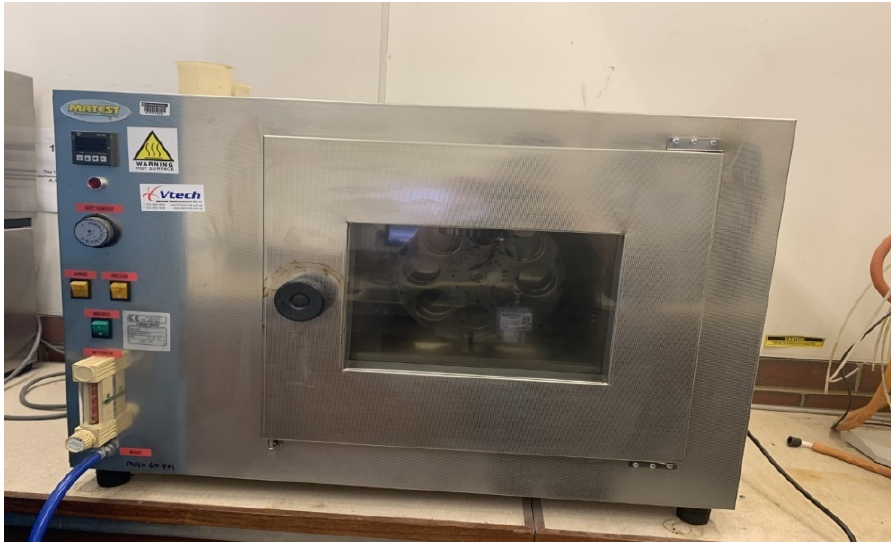
Figure 2. Apparatus of the RTFOT test at Curtin University.